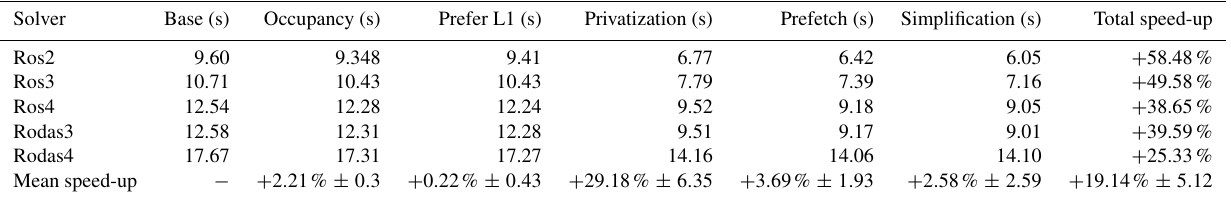
Table B1. Execution time in seconds and speed-up running the kernel on a M2070 CUDA-enabled accelerator placed in a node equipped with two Intel Xeon X5650 processors at 2.67GHz with synthetic input.